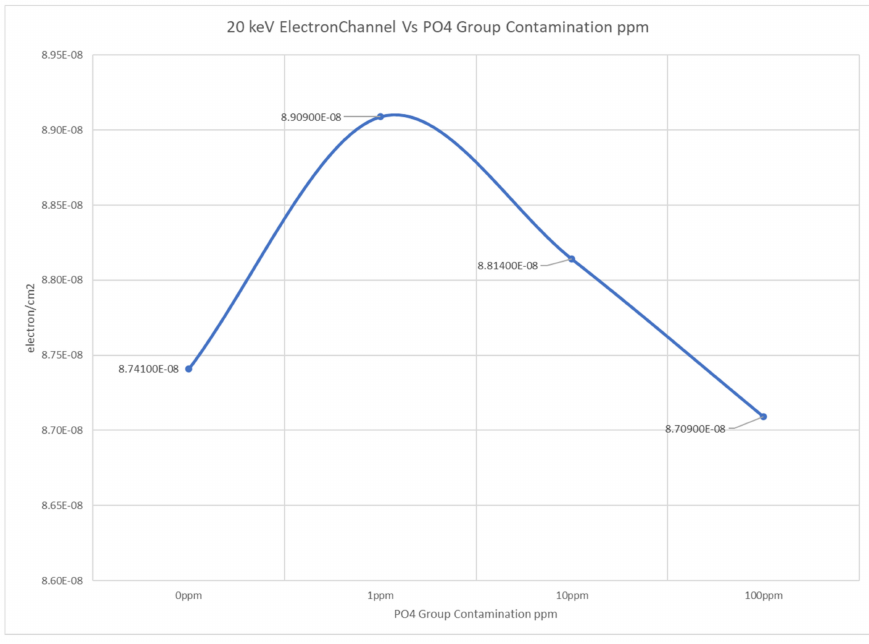
Figure 18. Electron 20 keV channel—air sample vs. contamination.